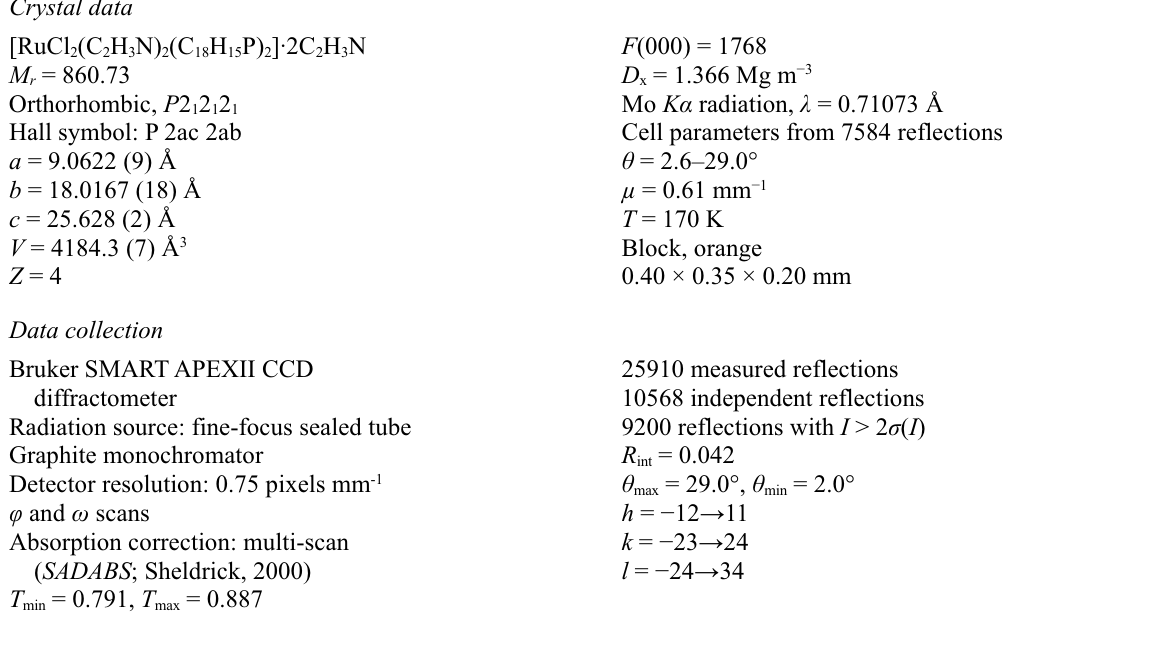
sup-3 Acta Cryst. (2008). E 64 , m184